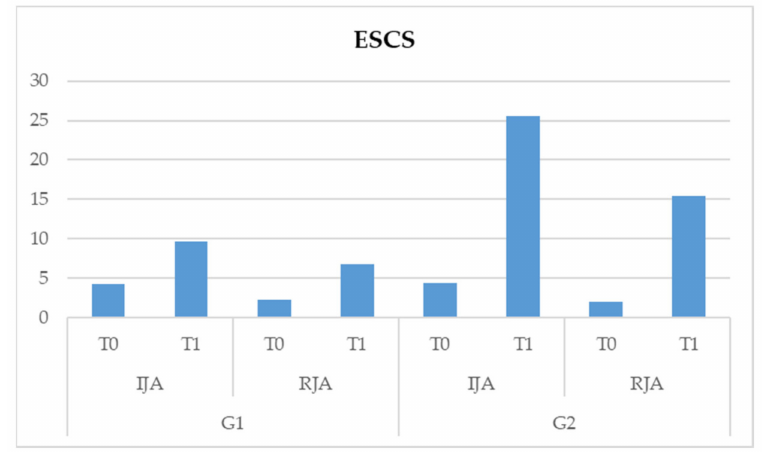
Figure 2. Effect of the scale * time * group interaction on the Early Social Communication Scales (ESCS) test.